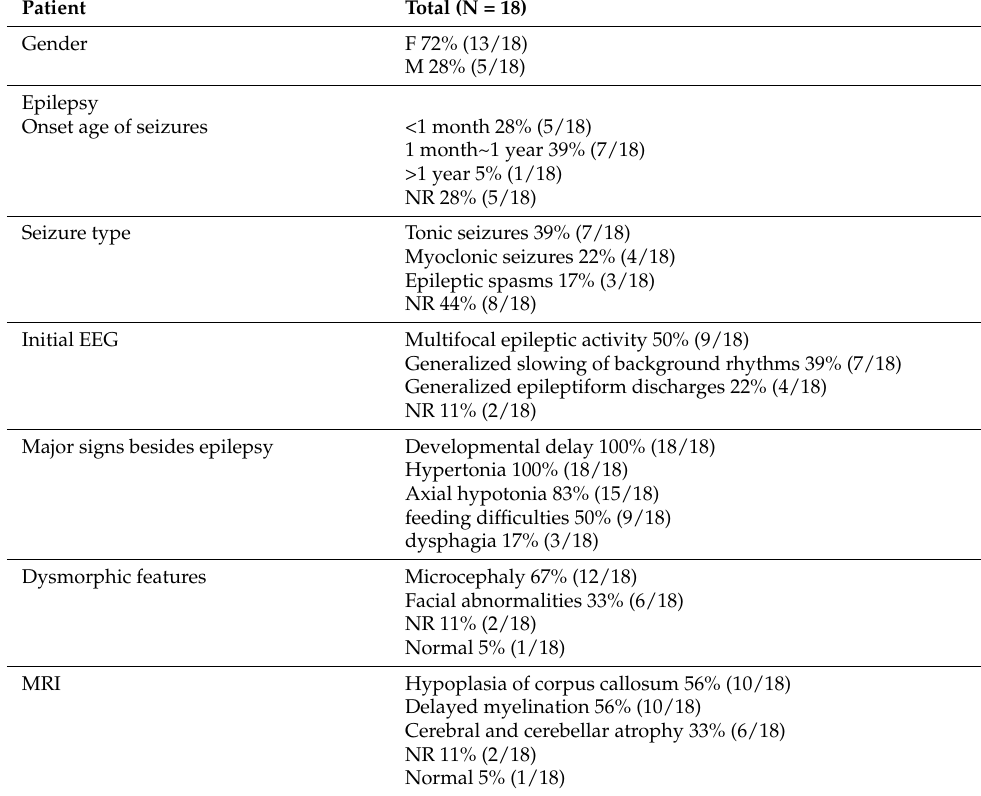
Table 1. Phenotypic features of 18 patients with ACTL6B recessive